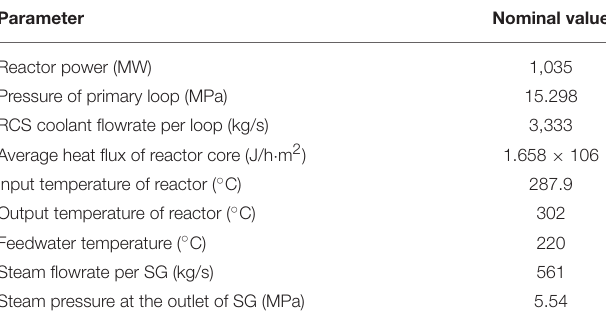
TABLE 4 | Nominal parameters for power operation mode.